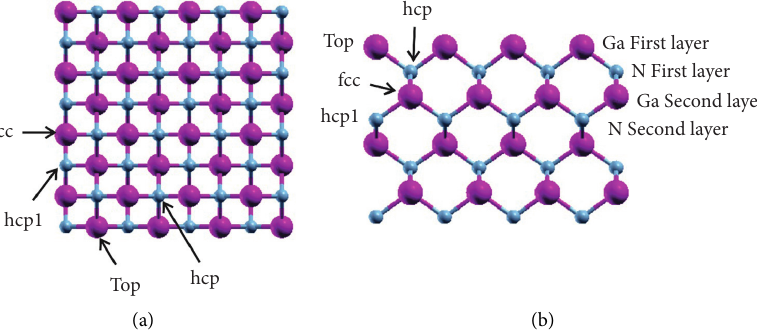
Figure 1: Schematic atomic structure for the Ga-terminated GaN (001)-(2 × 2) surface, showing high symmetry sites (top, hcp, fcc, and hcp1) for the monolayer Ge/C adsorption. (a) The top view. (b) The side